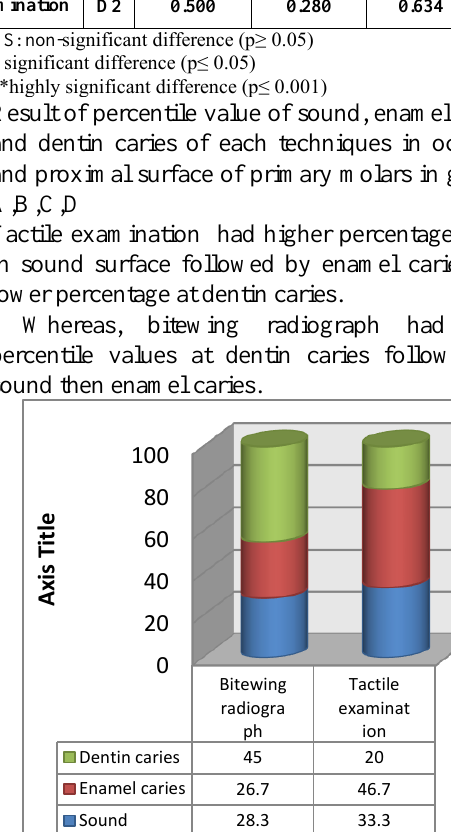
Figure 8: Receiver operating characteristic ROC plot: Tactile examination at dentin threshold for proximal surfaces Table 2: The sensitivity, specificity, accuracy and p-value for diagnostic techniques to detect secondary caries adjacent toamalgam restoration at enamel (D1) and dentin threshold (D2) in proximal surfaces for primary molars teeth.